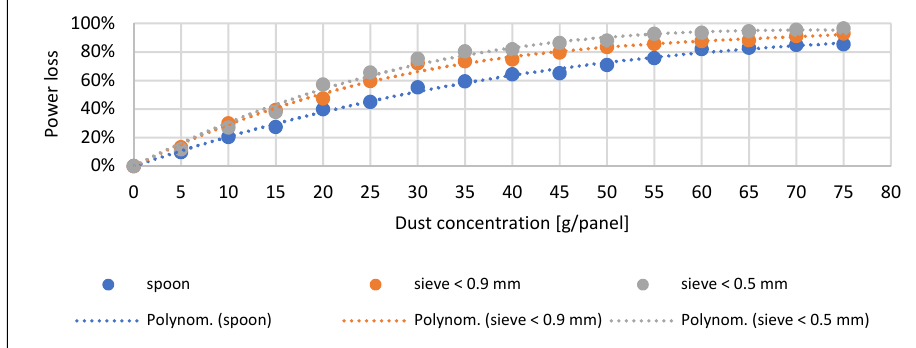
Figure 12. Power loss values as a function of the fly ash concentration.